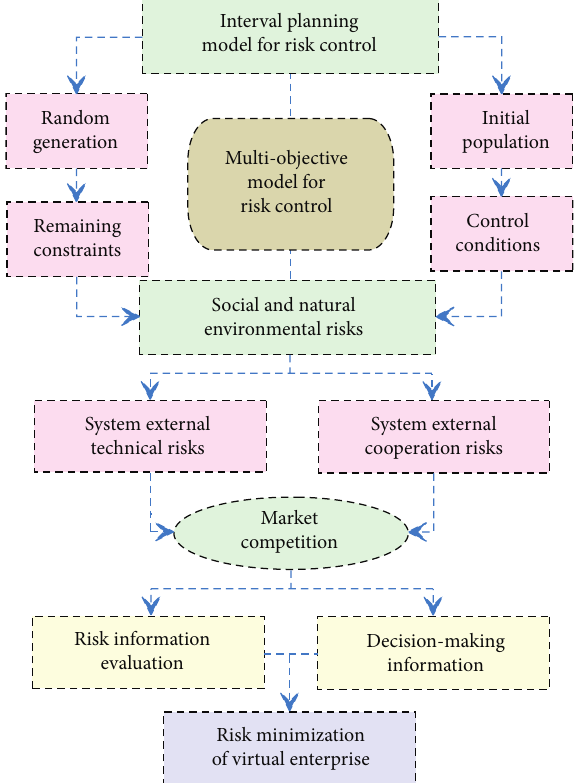
Figure 2: Framework of interval planning model for risk control based on distributed